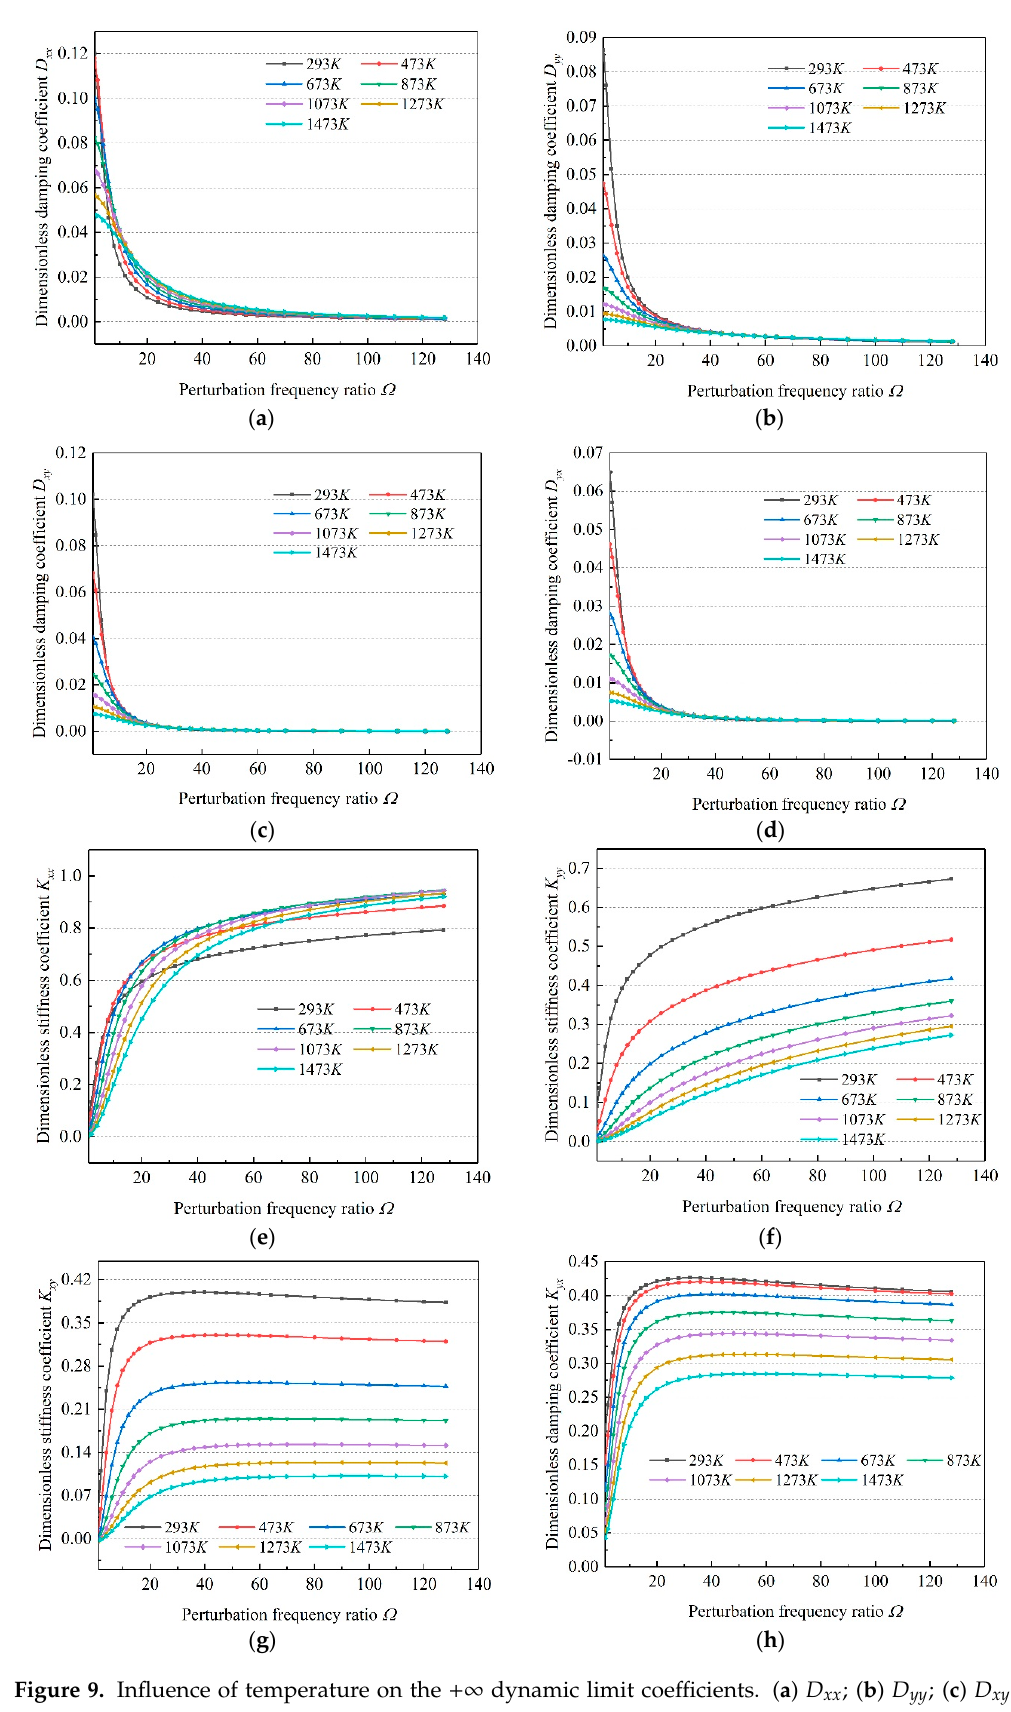
Figure 9. In fl uence of temperature on the + ∞ dynamic limit coefficients. ( a ) D xx ; ( b ) D yy ; ( c ) D xy ; ( d ) D yx ; Figure 9. Influence of temperature on the + ∞ dynamic limit coe ffi cients. ( a ) D xx ; ( b ) D yy ; ( c ) D xy ; ( e ) K xx ; ( f ) K yy ; ( g ) K xy ; ( h ) K yx . ( d ) D yx ; ( e ) K xx ; ( f ) K yy ; ( g ) K xy ; ( h ) K yx